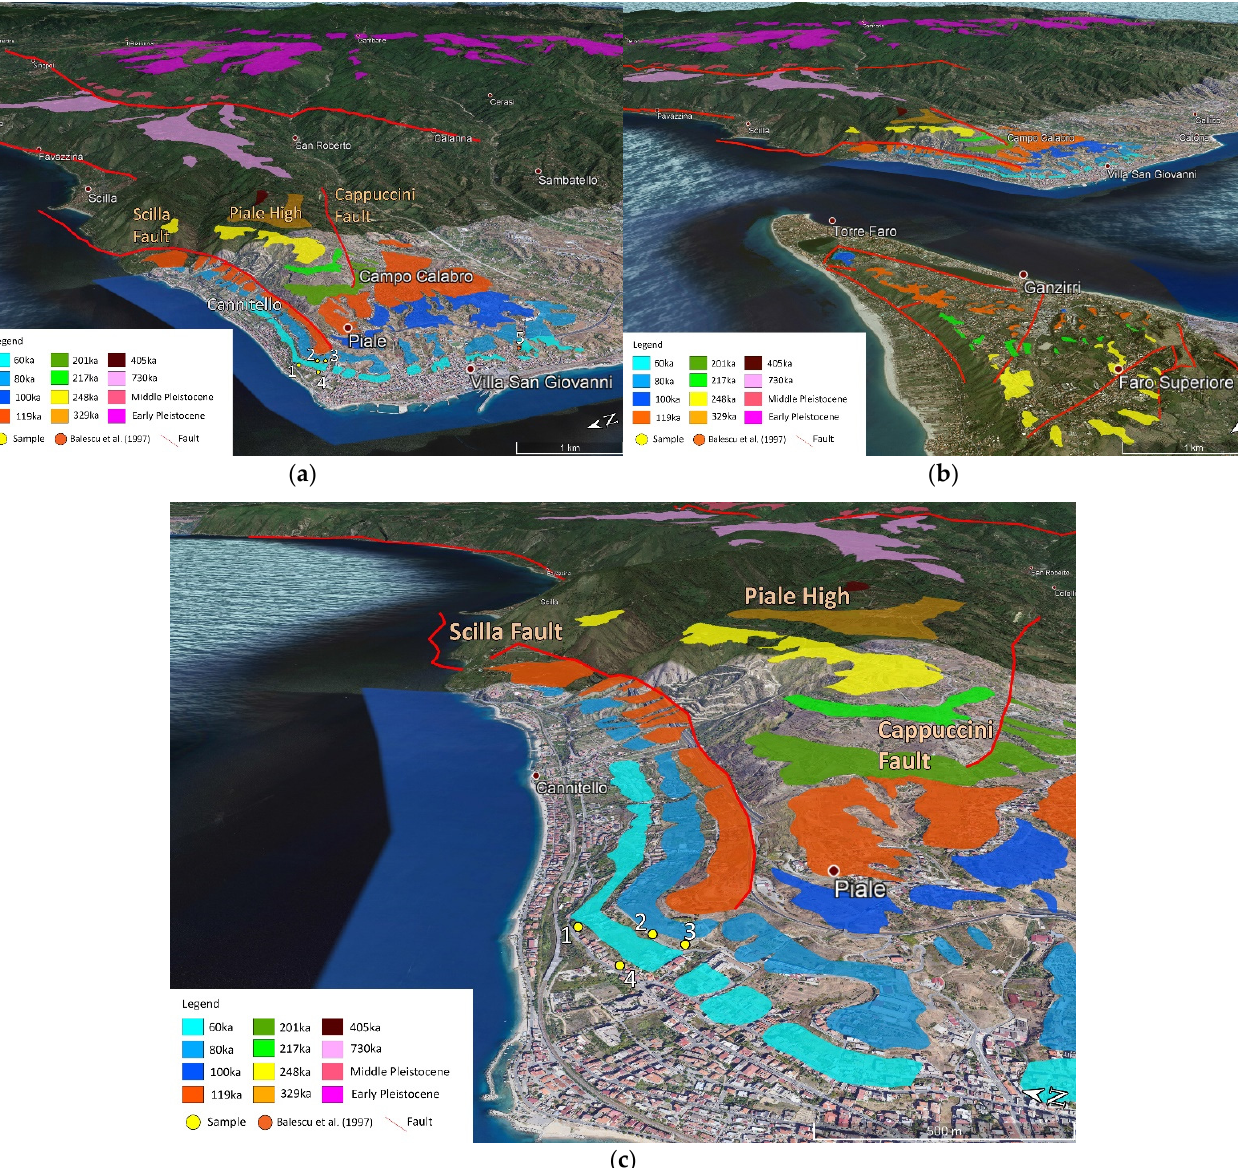
Figure 2. ( a ,b, c ) Maps of the terraced sequence (see Figure 1 for